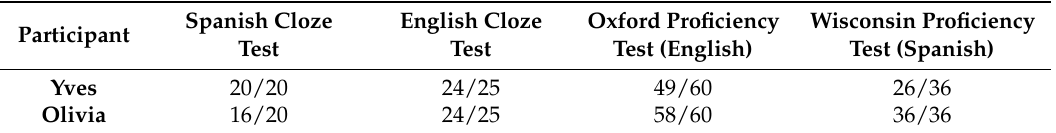
Table 2. Cloze and proficiency tests’ results for Yves and